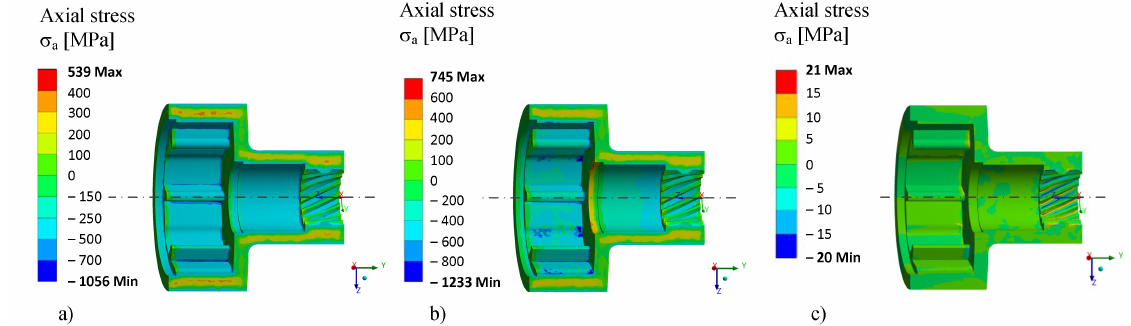
Figure 8. Axial stresses in the starter clutch barrel ( a ) after the heat treatment, ( b ) at the time of operation and ( c ) without the consideration of heat treatment at the time of